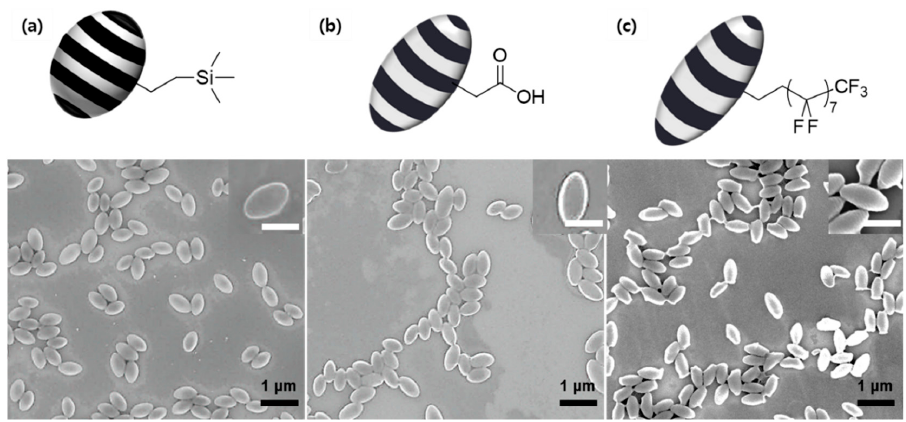
Figure 4. SEM images of the PS 34k - b -PB 25k particles’ MPA modification ( r = 0.5). Each particle was generated by membrane emulsification using different d pore , where pore sizes of ( a ) 0.5, ( b ) 1.1, and ( c ) 2.1 μ m were used, respectively. Figure 3. SEM images of PS 34k - b -PB 25k particles that are modified using ( a ) mercaptoethyl)trimethylsilane (MTMS), ( b ) MPA, and ( c ) perfluorodecanethiol (PFDT). The feed ratio of thiols to double bonds was fixed to r = 0.5. Scale bars in the inset are 500 nm.